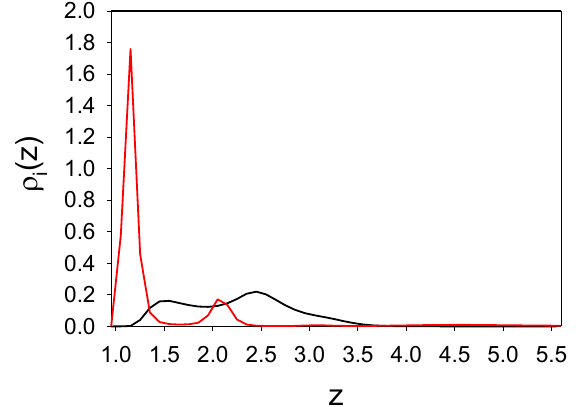
Figure 6. Adsorption at a surface for ¯ T = 0.25 and ρ g = 0.0021. Red and black lines represent average densities of the first and the second component, ρ 1 ( z ) and ρ 2 ( z ) , respectively, as functions of a distance z from the surface. The first and the second component interact with the wall with (3) and γ attr = 4, and with (4) and γ rep = 16, respectively. Simulations were performed for the initial number of particles N 0 =